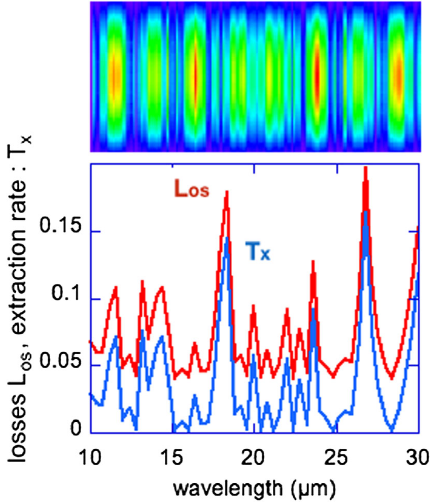
FIG. 27. Profile at λ ¼ 20 μ m, with a uniform gain and a slit of 2.5 mm width, and curve of losses and extraction rate vs wavelength.